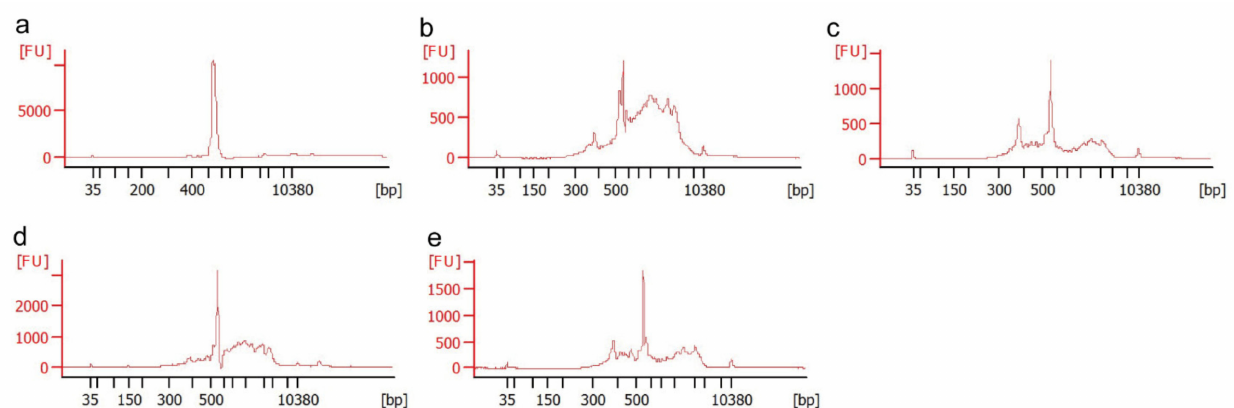
Figure 3. Fragment size distribution of amplicon libraries using different PCR and purification methods. Haemaphysalis longicornis (tick ID 3631) DNA was used as a template. The X - and y -axes show detected fragment size and fluorescent units, respectively. ( a ) PCR without blocker and AMPure purification; ( b ) PCR with TickB_PNA and AMPure purification; ( c ) PCR with TickB_PNA and SizeSelect purification; ( d ) PCR with TickB_LNA and AMPure purification; ( e ) PCR with TickB_LNA and SizeSelect